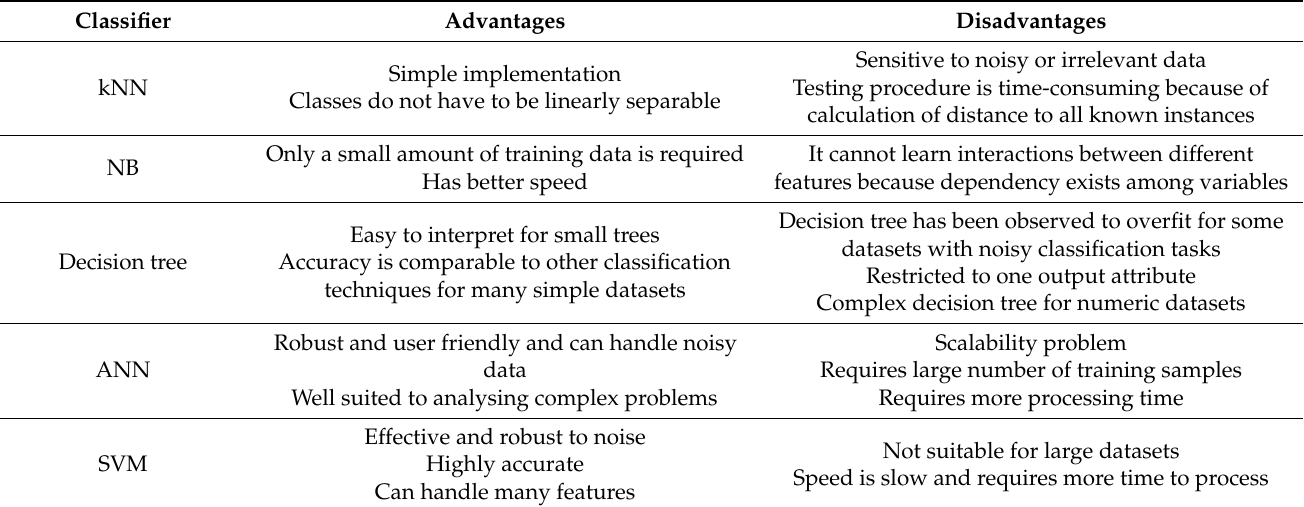
Table 6. Advantages and disadvantages of